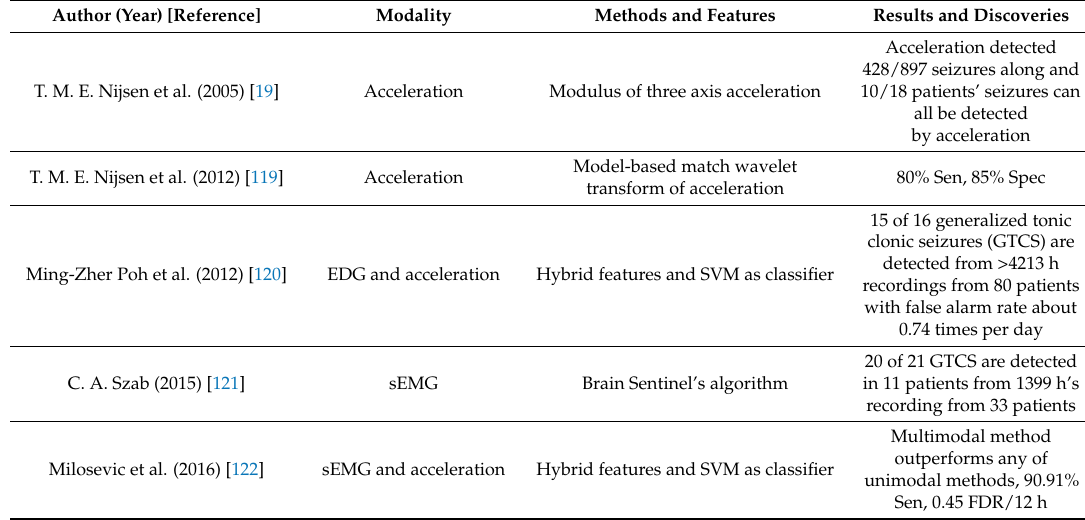
Table 5. Application of non-EEG based wearable sensor system in Epileptic Seizure